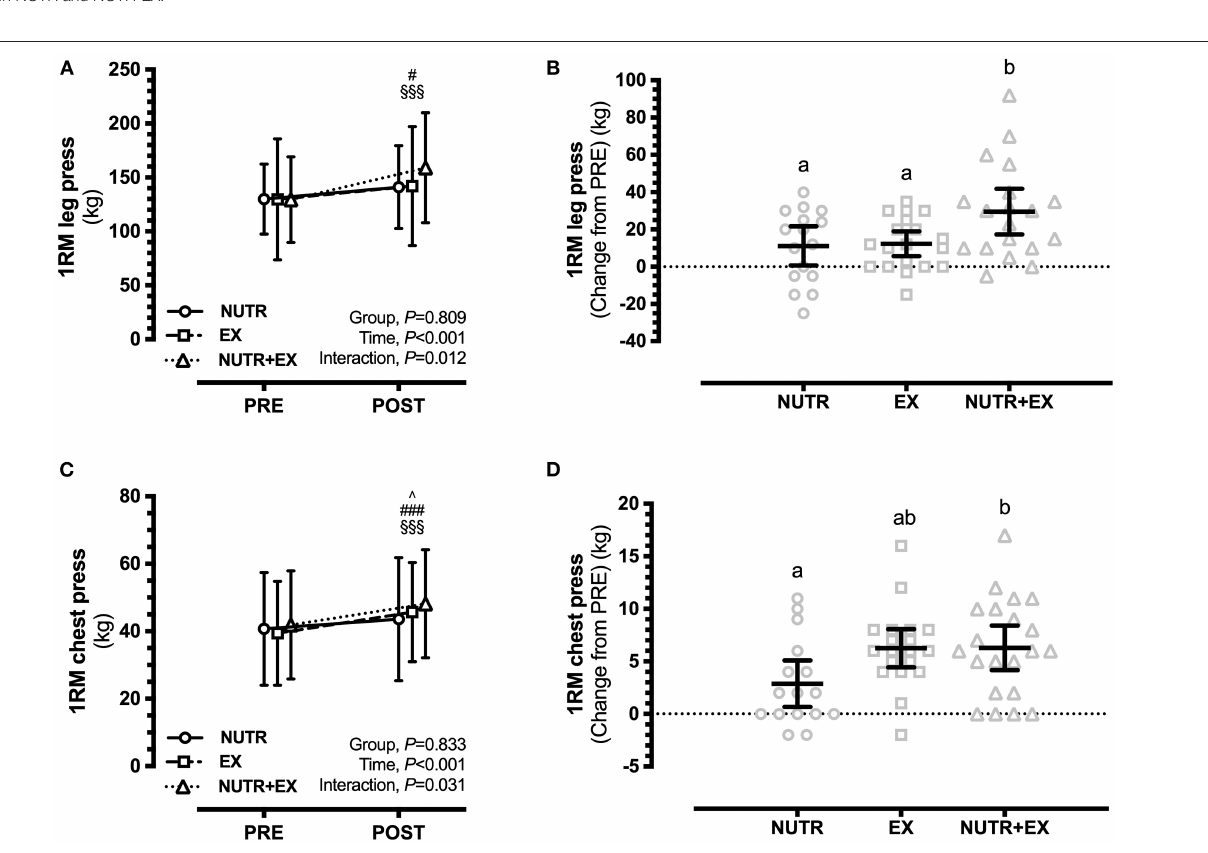
FIGURE 1 | Changes in lower and upper limb muscle strength assessed by 1RM in response to 12 weeks of concurrent aerobic and resistance exercise training with or without dietary intervention. (A) Group mean ± SD for leg press; (B) Individual data points and mean difference with 95% CI for gain scores from PRE for leg press; (C) Group mean ± SD for chest press; (D) Individual data points and mean difference with 95% CI for gain scores from PRE for chest press. ∧ denotes significant difference from PRE to POST within NUTR; ∧ P < 0.05; # denotes significant difference from PRE to POST within EX; # P < 0.05, ### P < 0.001; § denotes significant difference from PRE to POST within NUTR + EX; §§§ P < 0.001. Dissimilar letters demonstrate between-group differences ( P < 0.05) in panels ( B,D